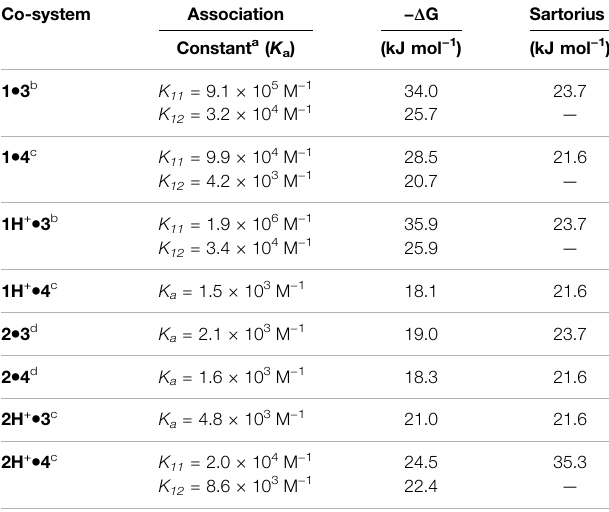
TABLE 1| Experimentallydetermined associationconstants for 1H + and 2H + with two different guest molecules, 3 and 4 , and their neutral parent complexes. Co-system